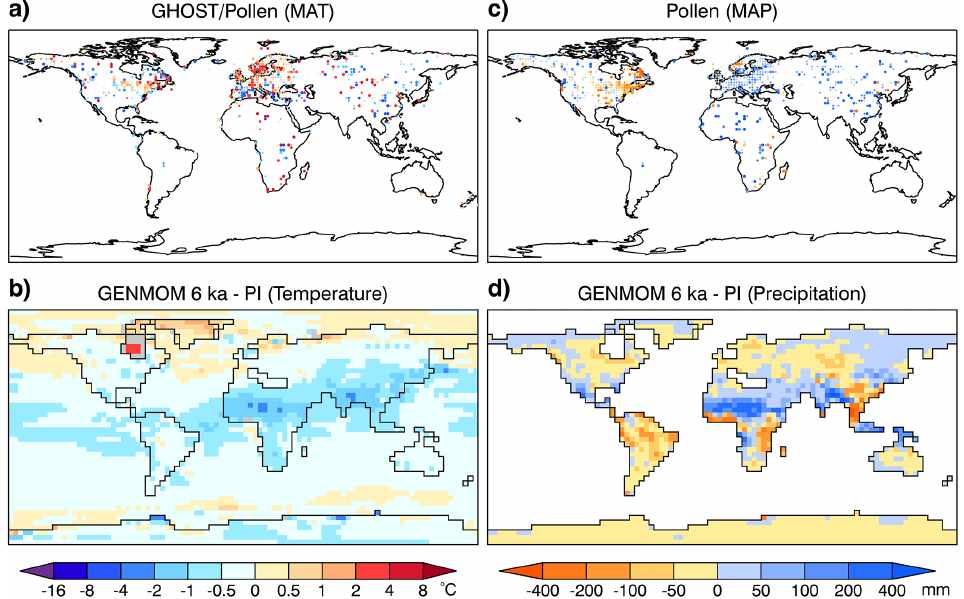
Figure 15. Changes in 6ka mean annual temperature (MAT) and precipitation (MAP) inferred from data and simulated by GENMOM. (a) Blended sea surface temperature from Leduc et al. (2010) and terrestrial temperature from Bartlein et al. (2011), (b) GENMOM tem- perature anomalies (blended sea surface temperature and 2m air temperature over land), (c) precipitation from Bartlein et al. (2011), and (d) GENMOM precipitation anomalies. Grid cells with different land mask types in the 6ka and PI simulation are shaded in gray to avoid comparing ocean temperature to land temperature in emergent